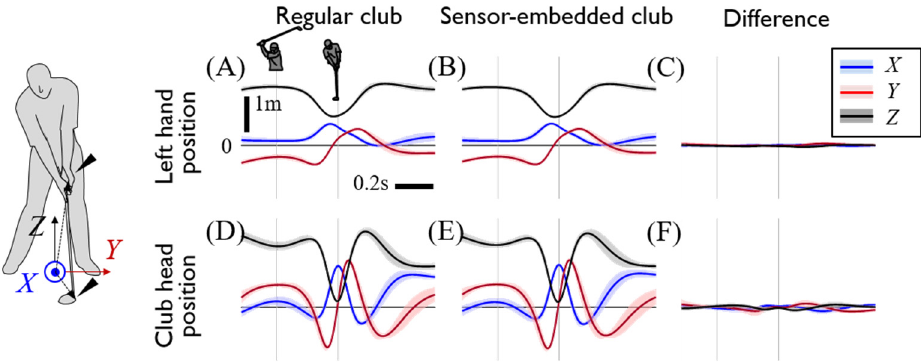
Figure 3. Swing motion data according to the used club type. Each row shows the position of the left hand ( A–C ) and clubhead ( D – F ). The first two columns show the motion data when the subject used a regular driver and the sensor-embedded driver, and the last column shows the difference. The blue, red, and black lines indicate the x , y , and z positions at the global coordinates, respectively. All motion data were the averages of driver swing data on all subjects. The two thin gray vertical lines indicate the backswing top and impact.